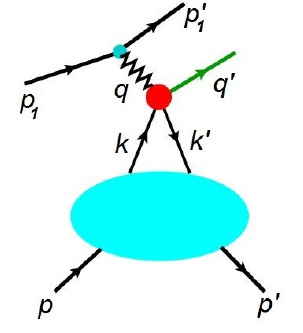
Figure 4. Meson production in hadron reactions. The zigzag line shows the gluon and the strong interaction contribution (Odderon, see the text)